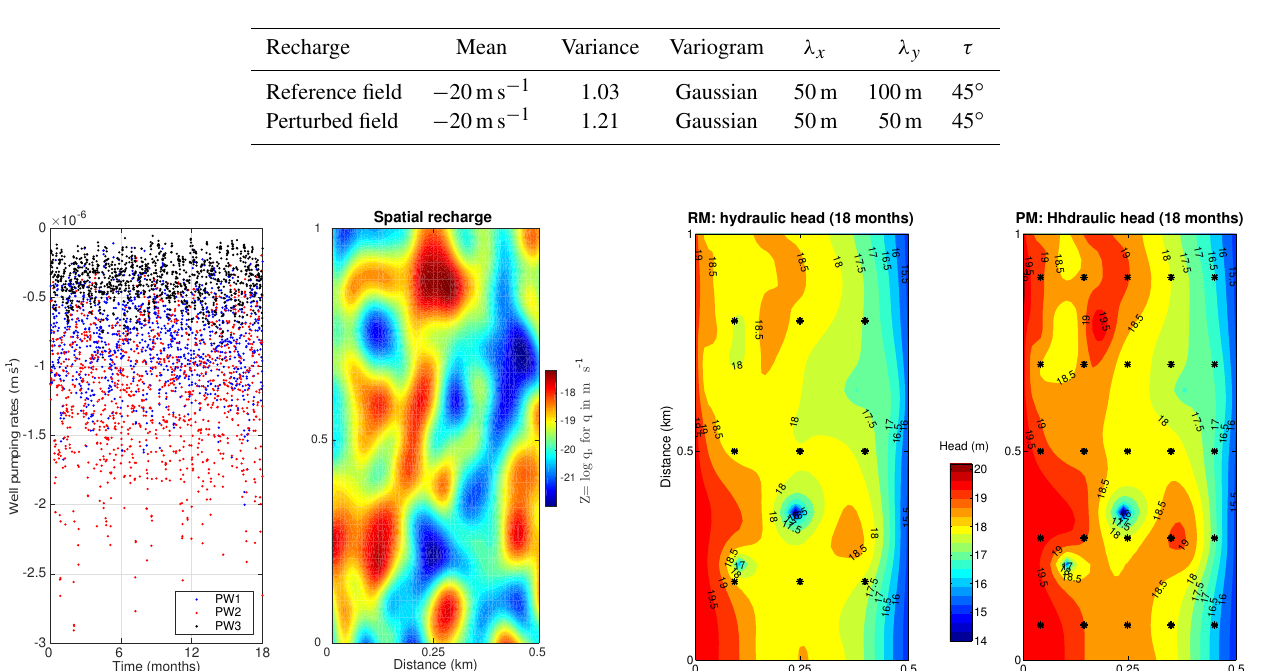
Table 2. Parameters of the random functions for modeling the spatial distributions of the reference and perturbed recharge fields. The ranges in x and y directions for the variogram model are given by λ x and λ y , respectively. τ denotes the rotation angle of one clockwise rotation around the positive y axis.